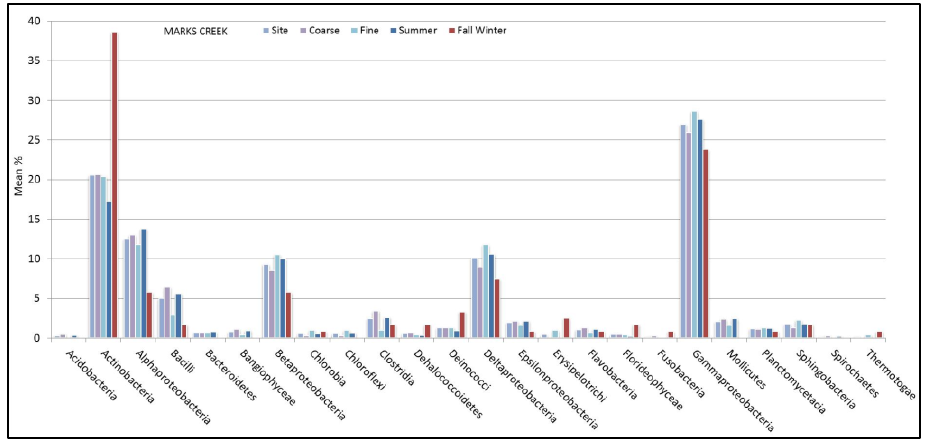
Figure 4. Marks Creek mean % values of OTU matches for bacterial class represented by sediment size and seasonal sampling period.